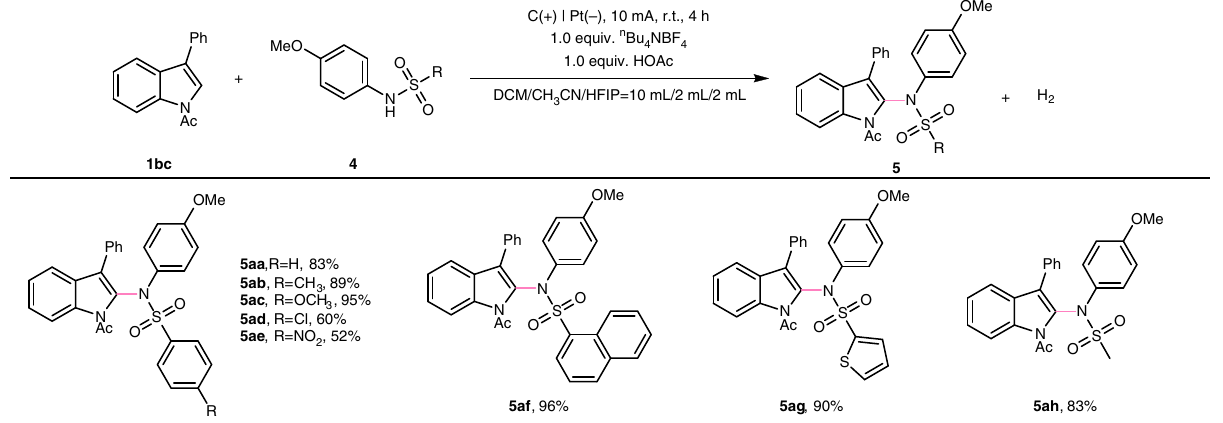
Fig. 4 Substrate scope of sulfonamides. Reaction conditions: carbon rod anode, platinum plate cathode, constant current = 10 mA, 1aa (0.40 mmol), 4 (0.60 mmol), n Bu 4 NBF 4 (0.40 mmol), HOAc (0.4 mmol), solvent (DCM/ CH 3 CN/ HFIP = 10 mL/2 mL/2 mL), undivided cell, N 2 , 4 h. Isolated